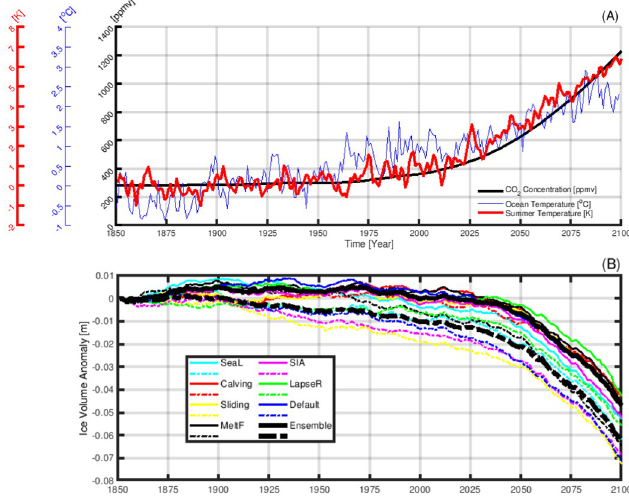
Fig 6. The evolution of Greenland’s climate and ice volume during 1850–2100. (A): Black line: concentration of CO 2 forcing in our climate model simulation. Blue line: yearly mean ocean temperature forcing. Red line: Greenland- wide summer temperature anomalies in respect to the Pre-Industrial values (100 years of climatology mean). (B): Anomaly of ice volume of the GrIS with respect to the Pre-Industrial values. The solid lines are the simulations using initial conditions obtained by the paleo-spinup, while the dashed lines are the results using initial conditions obtained by a ten thousand year Pre-Industrial equilibrium-spinup. The coloured lines are the results from individual ensemble members (see Table 1), and the thick black lines are the results of the ensemble mean.